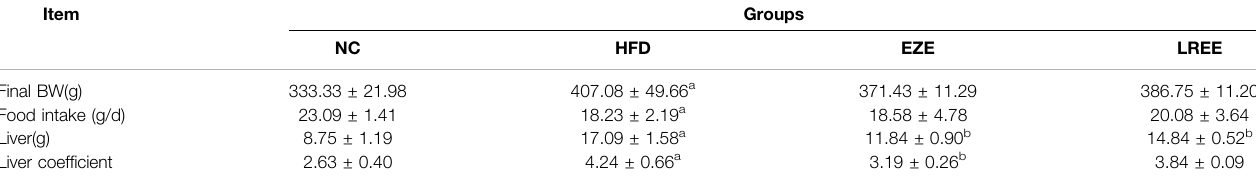
TABLE 2 | Effect of LREE on the body weight, body composition, and food intake in rats fed with HFD.